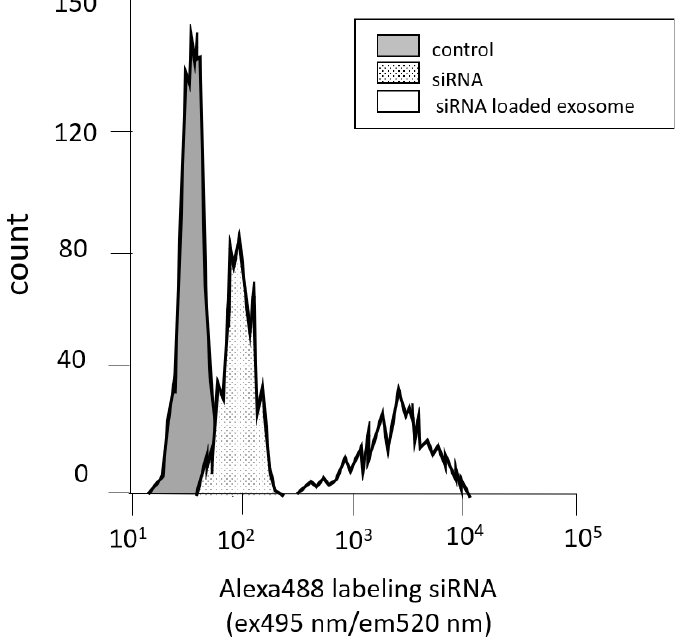
Figure 1. Assessment of cellular uptake by B16/BL6 cells treated with Alexa488-labeled siRNA- loaded exosomes derived from the serum of healthy mice using flow cytometry.